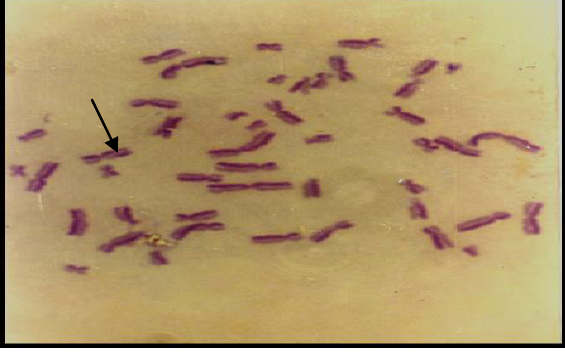
Figure, 1: Microphotographs of sister chromatid exchanges in metaphase chromosomes by fluorescent plus Giemsa staining (1000X) . Table, 1: The SCE and mutant frequency- HPRT gene for the control group and workers in nuclear center destroyed at Al-Tuwaitha site (Mean ±SE). Studies No. of Mutant Frequency- groups Samples HPRT (Mean ± SE) Radiation group Control